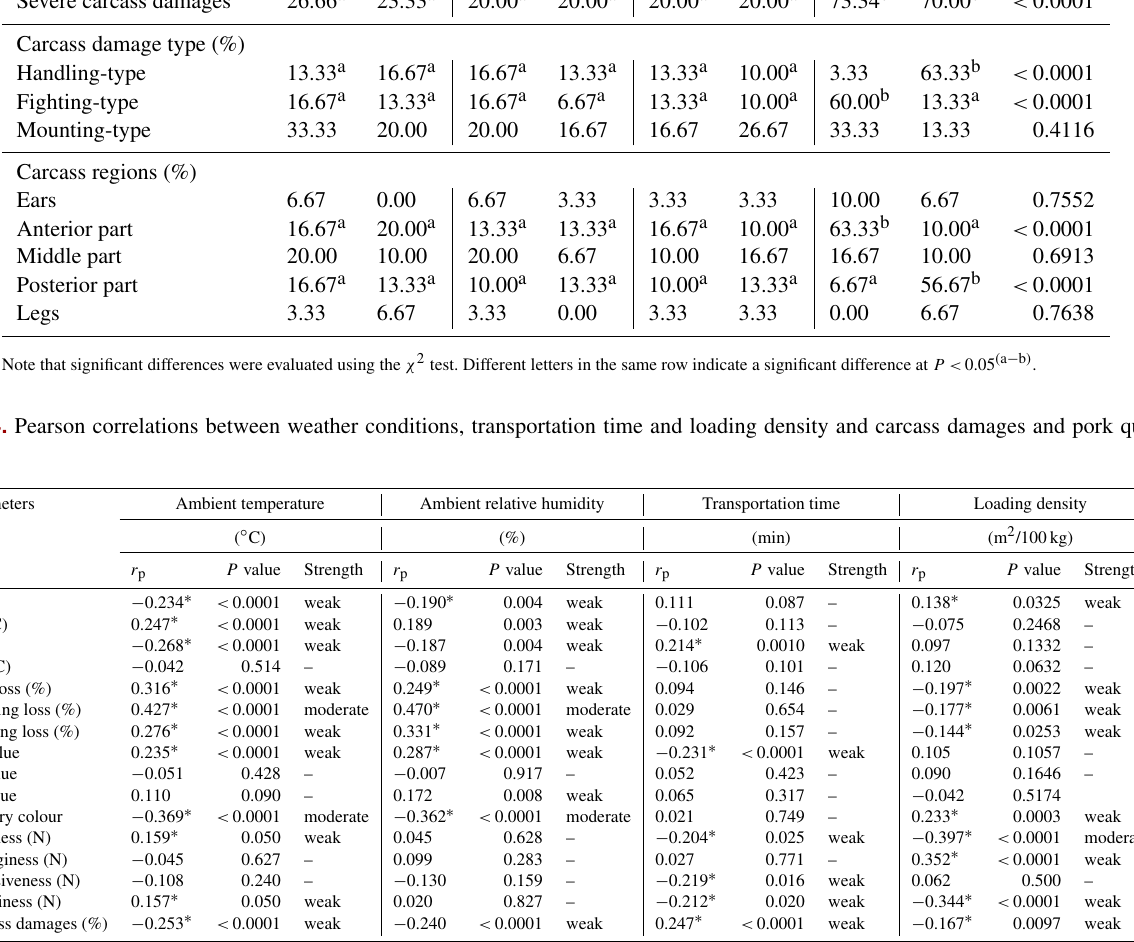
Table 3. The combined effects of weather conditions, transportation time and loading density on the prevalence of carcass damages ( n = 240). Weather conditions Hot Transportation time Loading density Number of pigs Carcass damages (%)